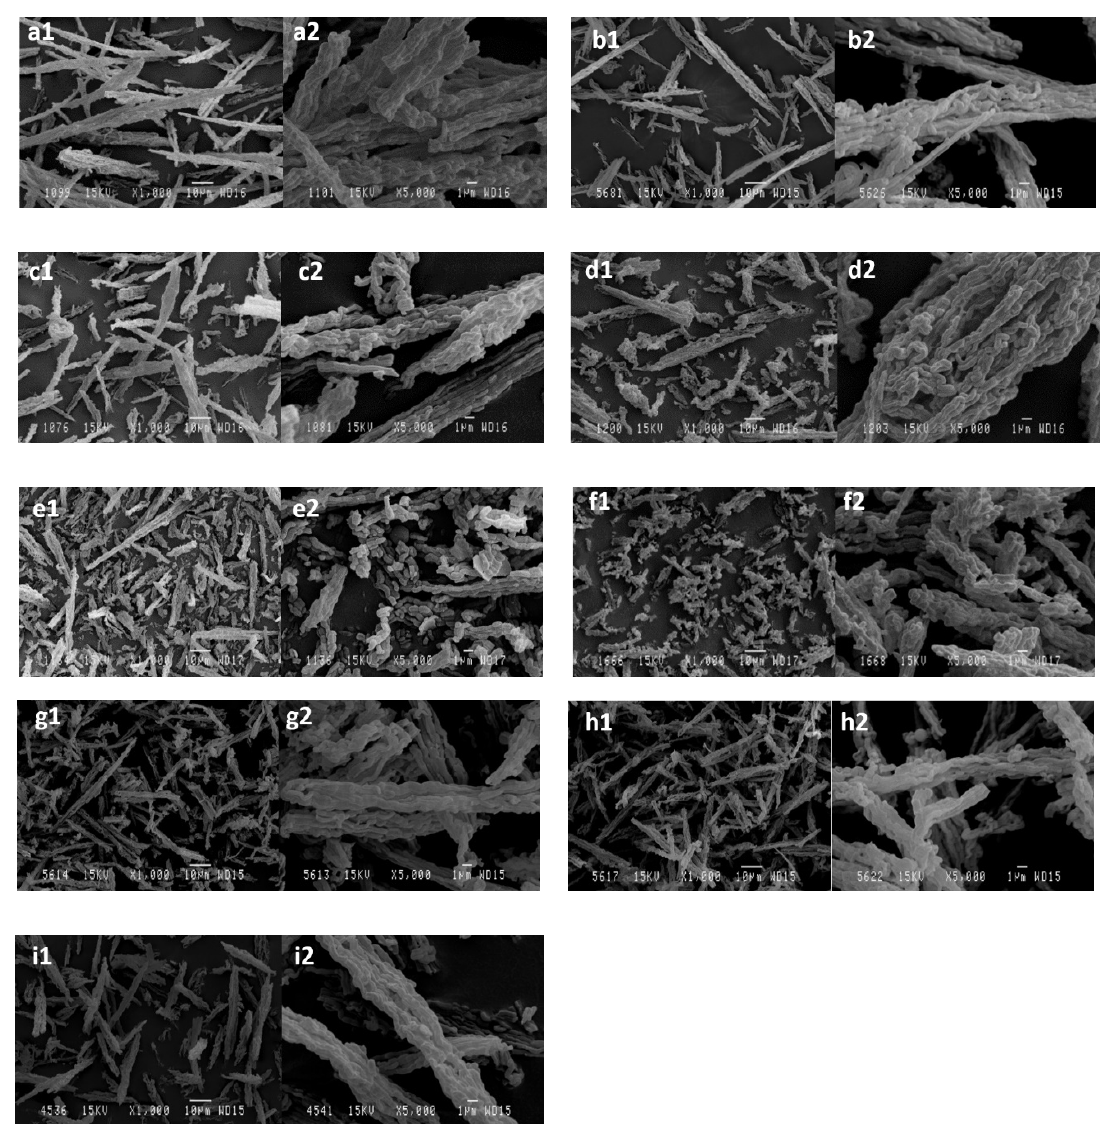
Figure 7. SEM micrographs of the SBA-15 catalyst synthesized: ( a ) 24/80*, ( b ) 24/80, ( c ) 24/100*, ( d ) 24/100, ( e ) 24/130, ( f ) 0/80, ( g ) 2/80, ( h ) 6/80, and ( i ) 15/80, at two different magnifications. *Synthesis developed without reducing the supernatant liquor before the hydrothermal treatment.